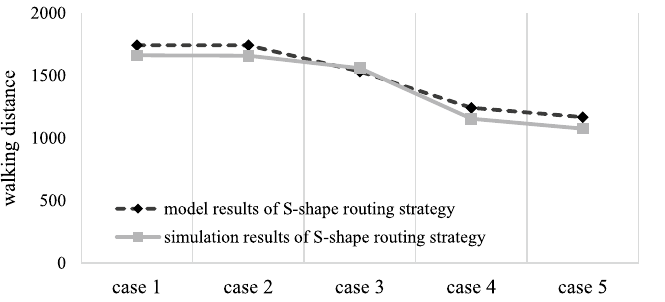
Figure 6. Comparison of the stochastic model results and simulation results for the S-shape routing strategy.